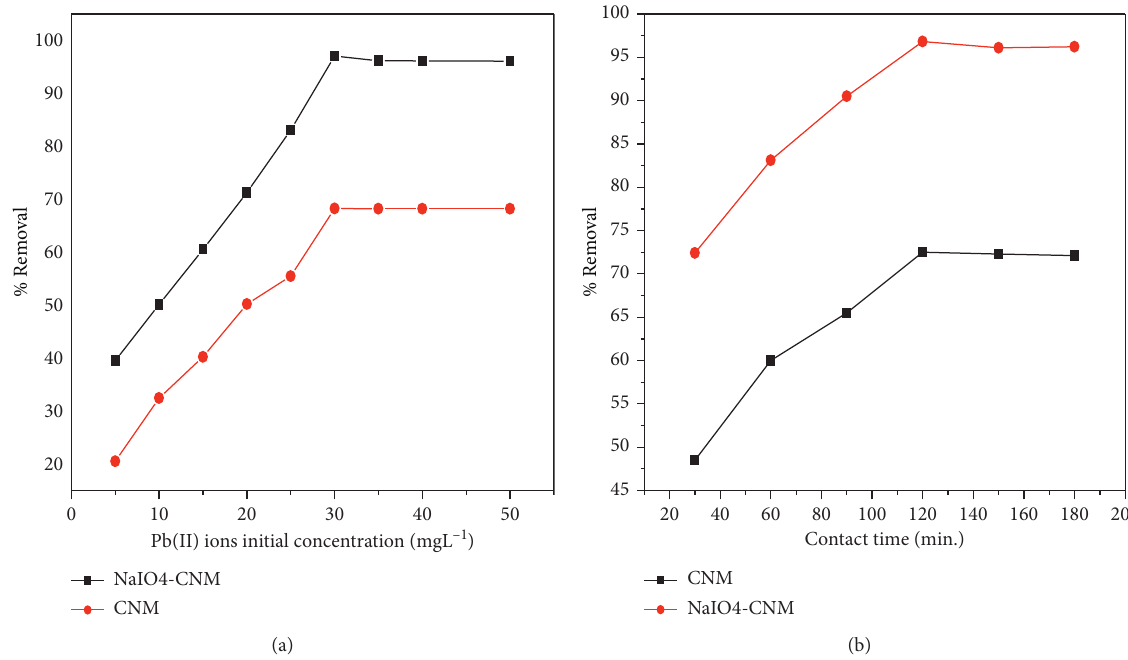
Figure 4: The effect of (a) initial concentration and (b) contact time for the removal of Pb(II) ions from wastewater, respectively, at optimum temperature of 25 ° C, adsorbent dosage of 1, solution pH of 6, and agitation speed of